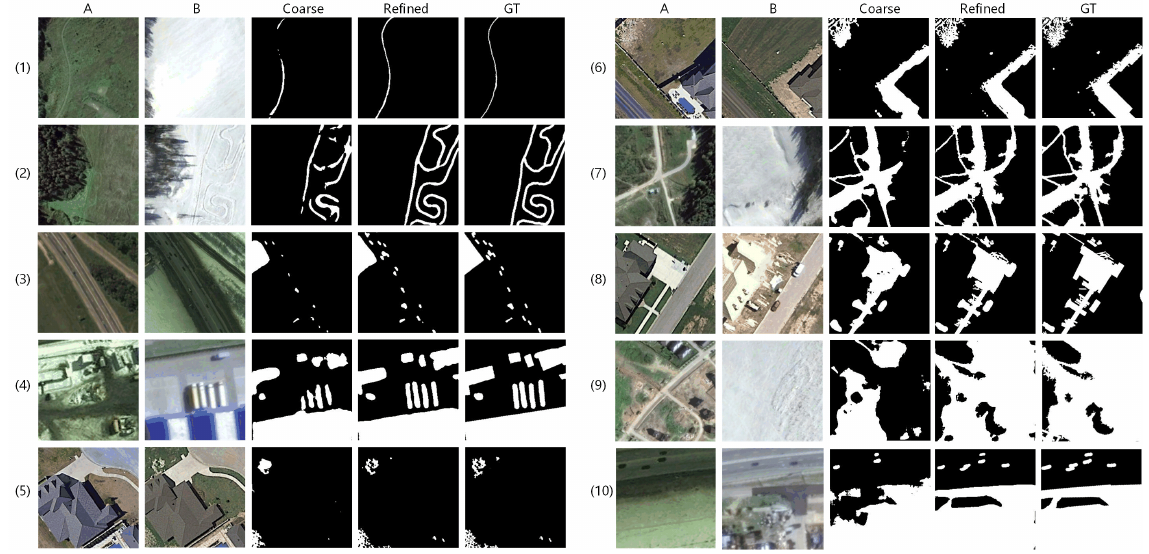
Figure 5. Qualitative comparison between coarse detection and refined